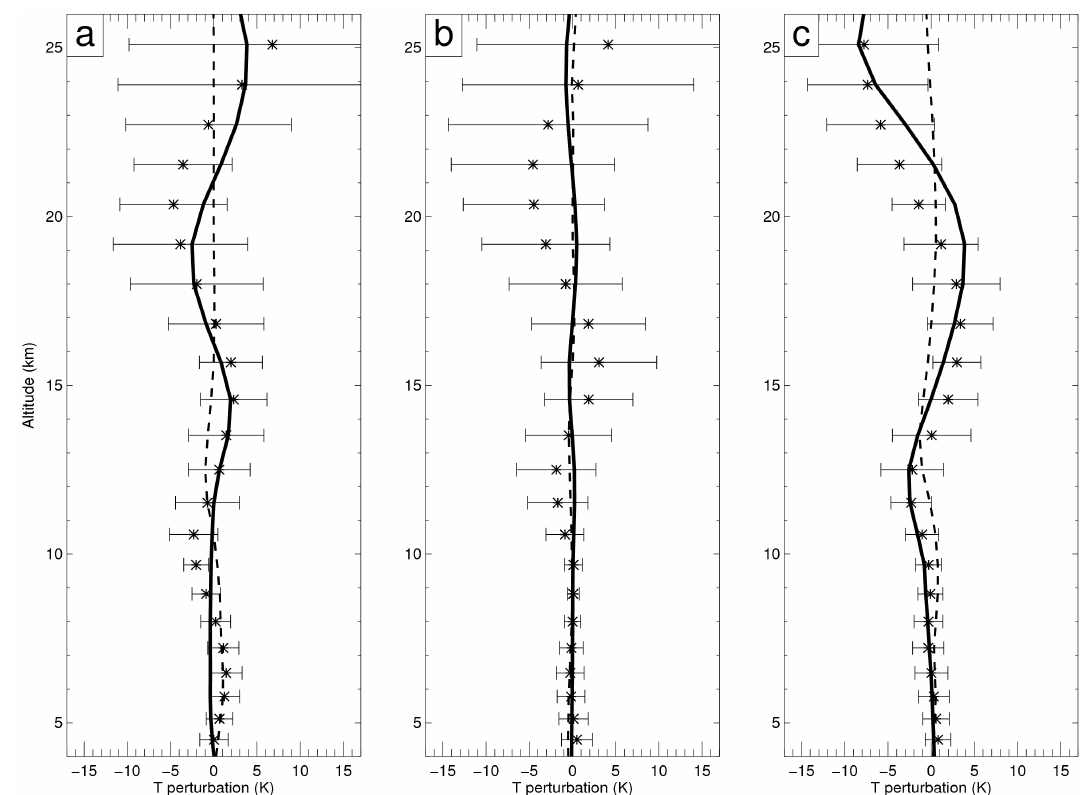
Figure 5. Vertical profile of temperature fluctuations (K) resolved by the climate model (dashed line), resolved by the mesoscale model (stars and horizontal bars), and parameterised by the mountain wave scheme (cid:49)T SSO (solid line) at the time of the CS1 (a) , CS2 (b) , and CS3 (c) mountain wave events. See Table 1 for dates. The temperature fluctuations resolved by the climate model and parameterised by the scheme are for the grid boxes located at (70 ◦ S, 63.75 ◦ W) for CS1, (65.0 ◦ S, 60.0 ◦ W) for CS2, and (70.0 ◦ S, 60 ◦ W) for CS3, i.e. selected to coincide with the location of their respective mountain wave events. These locations are displayed in Fig. 3. The mesoscale model temperature fluctuations are the mean (stars) and spread ( ± 2 standard deviations, horizontal bars) of all the mesoscale model points within the same climate model grid box.